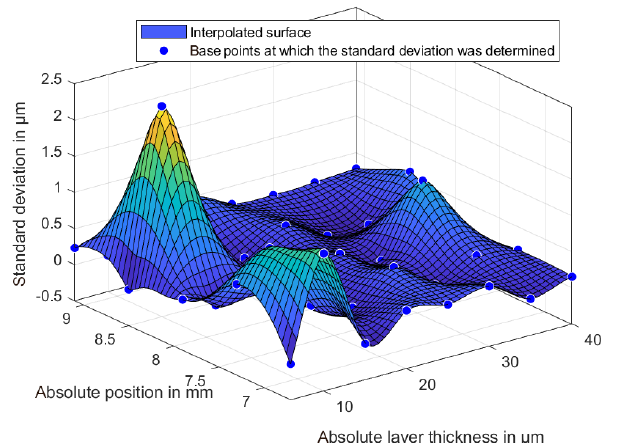
Figure 13. Deviation of the measured BF152DL layer thicknesses at a temperature of 25 ◦ C to the reference measurement at 20 ◦ C.